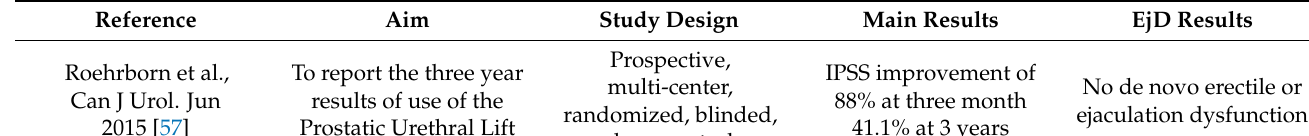
Table 10. Impact of Urolift procedure on the ejaculatory status.